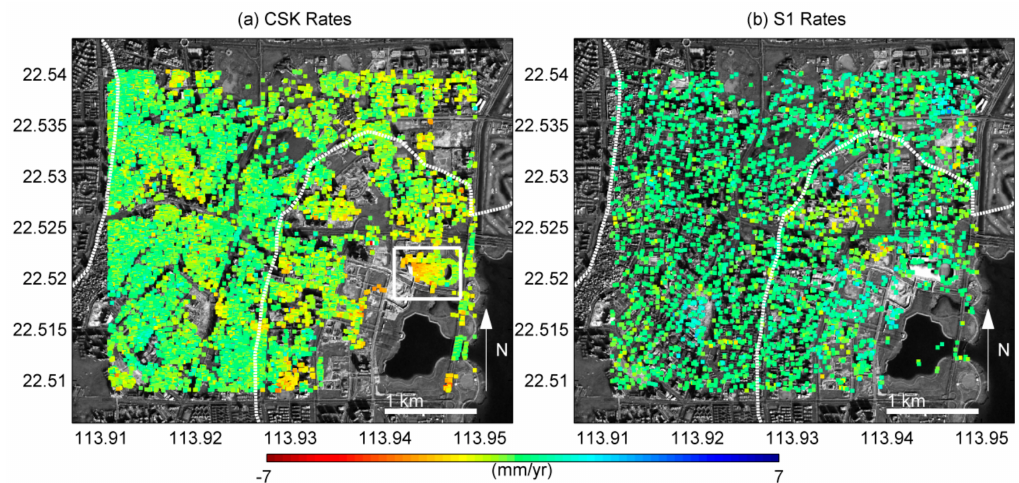
Figure 8. ( a ) CSK and ( b ) S1 mean rates in Houhai area. The white dashed line is the coastline in 1979. The white solid rectangle outlines the Shenzhen Bay Sports Center (also known as Spring Cocoon).